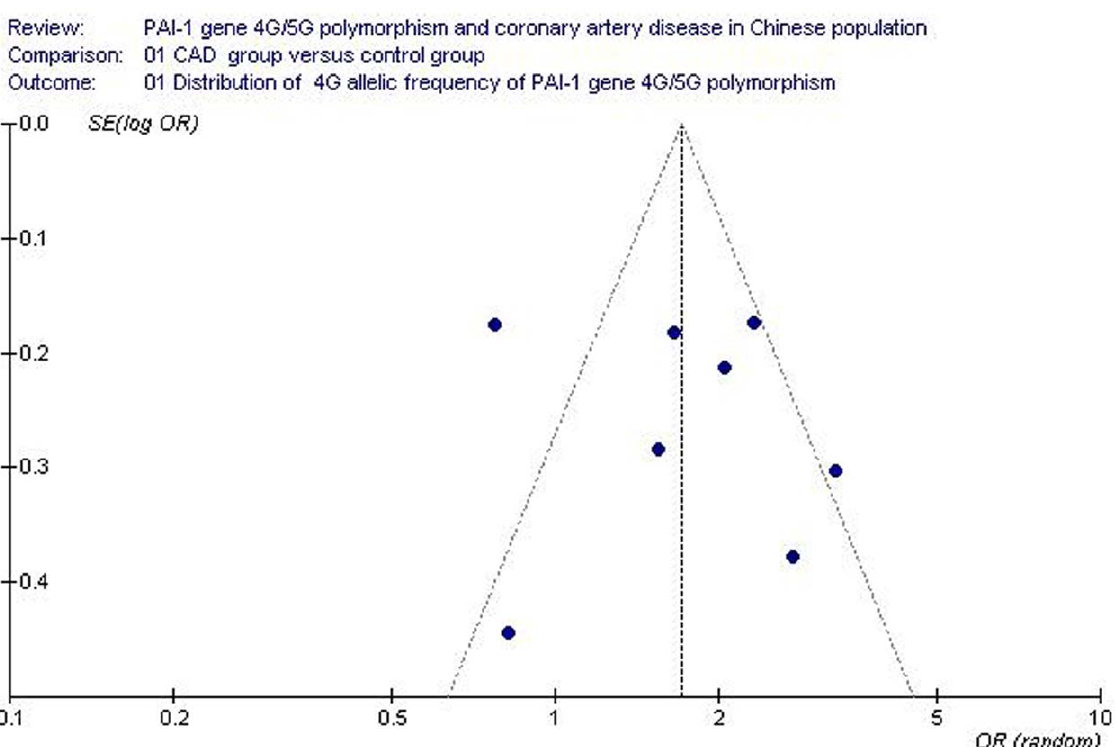
Figure 3. Funnel plot for studies of the association of coronary artery disease and plasminogenactivatorinhibitor-1 4G/5G gene polymorphism (distribution of 4 G allelic frequency of plasminogenactivatorinhibitor-1 4G/5G gene). The horizontal and vertical axis correspond to the OR and confidence limits. OR: odds ratio; SE: standard error.